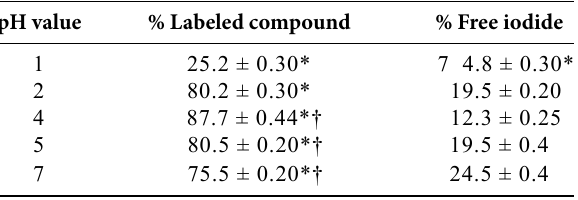
Table 7. In-vitro stability of 125 I -TP 5